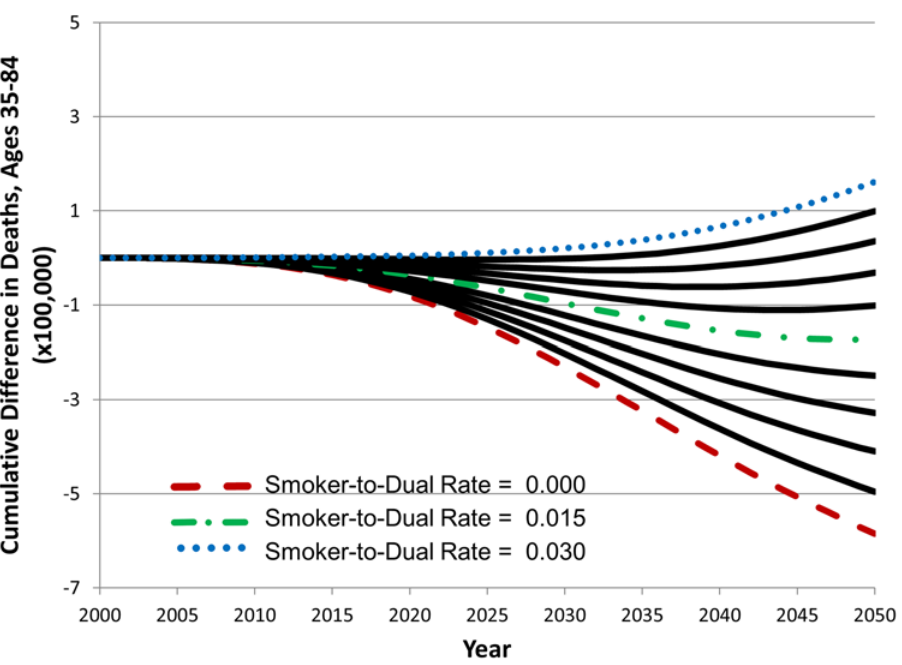
Fig 8. The effect of changes in smoker to dual use transition rate values on cumulative difference in deaths between the status quo and hypothetical scenario A, 2000 – 2050.